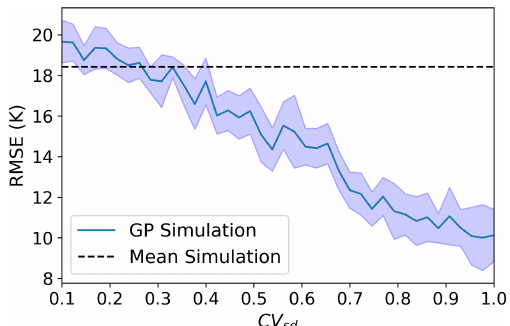
Figure 9. Overall RMSE (year and site) with the mean simulation (dashed black line) and the GP simulation in blue as a function of the coefficient of variation of snow